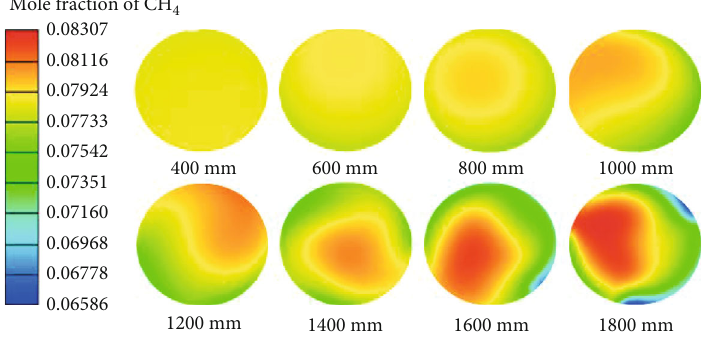
Figure 7: In fl uence of blade pitch on the uniformity in mixing zone.